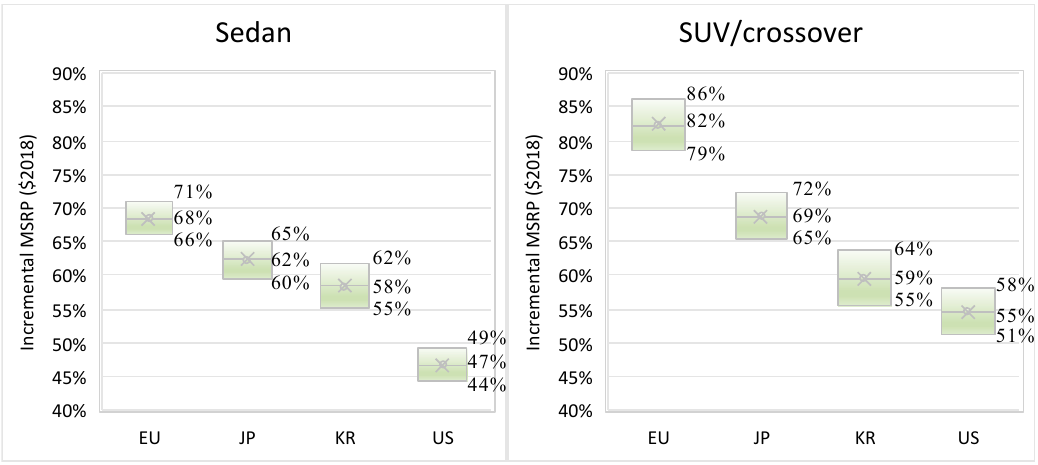
Figure 13. The relative impact of brand on vehicle MSRP, relative to the vehicles in Chinese brands.